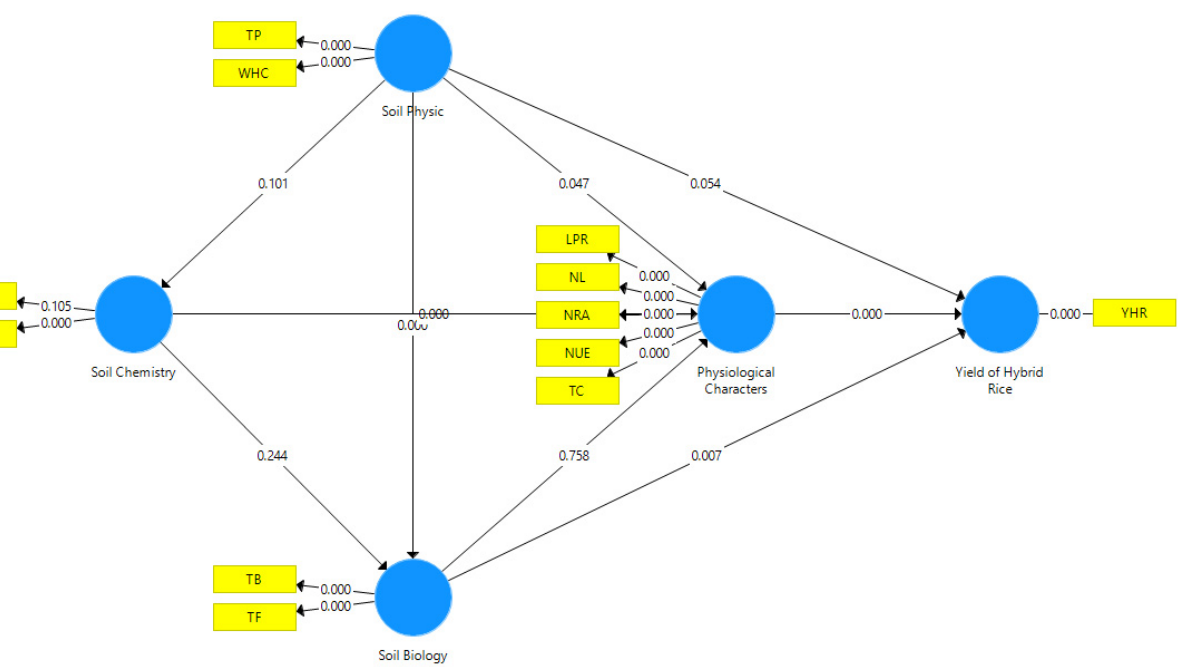
Table 7. Optimized value of in situ biochar briquettes and nitrogen fertiliser for response variables.